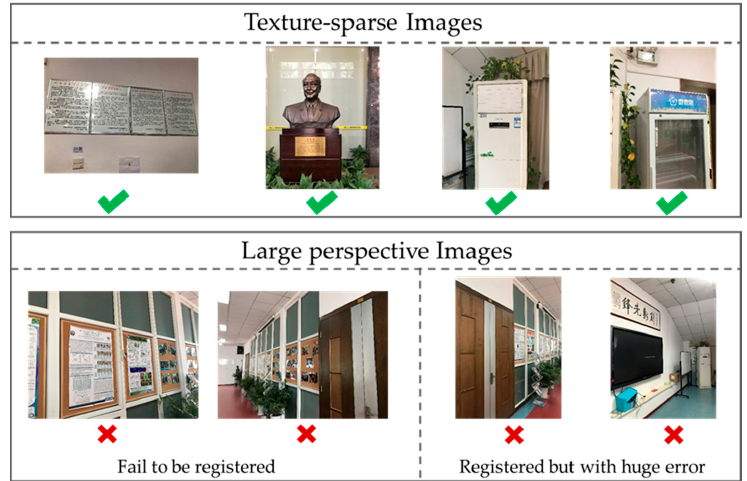
Figure 10. Examples of query images: The images in the first row have sparse textures but were successfully registered. The images in the second row could not be localized for large perspective, the left two pictures were not registered, while the right two pictures were registered but with huge errors.